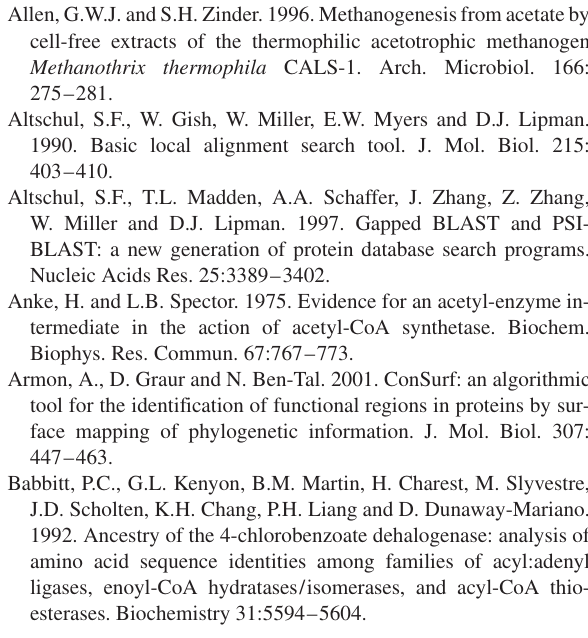
Figure 5. The acetate binding pocket of MT-ACS1 and AF-ACS2. (A) MT-ACS1 and (B) AF-ACS2 were modeled on the S. enterica ACS struc- ture (PDB: 1PG4) using Accelrys DS Modeler 1.1 and the stereo image of the putative active site acetate binding pocket was created using DS ViewerPro 5.0. Residues within a 10 Å sphere of the propyl moiety of the propyl- phosphate group of the adeno- sine-5’-propylphosphate mimic of the acetyl-adenylate inter- mediate are shown. The acetate pocket residues (Ile 312 , Thr 313 , Val 388 , and Trp 416 of MT-ACS1 and Ile 329 , Thr 330 , Val 405 , and Trp 433 of AF-ACS2) are col- ored and labeled. Those resi- dues with high ConSurf scores that differ between MT-ACS1 and AF-ACS2 are shown in or- ange. Residues discussed in the text are labeled and shown in dark green. The propylphos- phate group is shown in